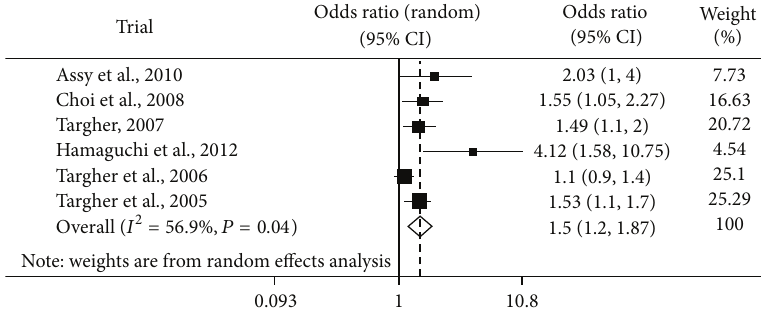
0.093 Figure 3: Summary estimates (after adjustment for confounders) for Mantel-Haenszel odds ratios, the corresponding 95% CI limits, and significance ( 𝑃 value) were estimated by random effects metaregression analysis for cardiovascular disease with NAFLD